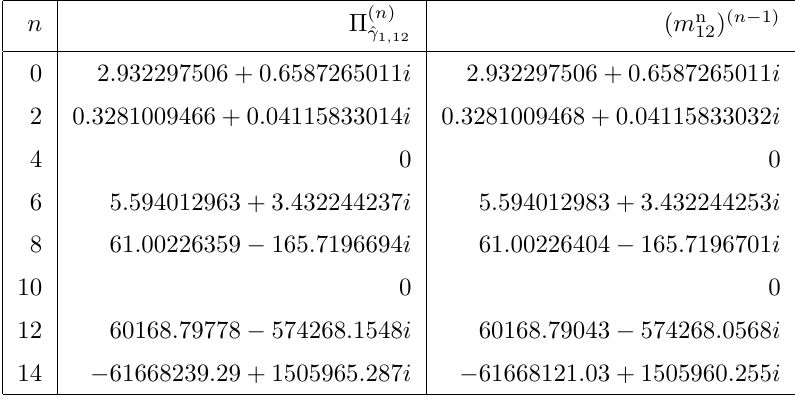
Table 5. Π ( n ) and ( m n ) ( n − 1) for the third order ODE with p ( x ) = − x 3 − ix 2 + (1 − i ) x 12 ˆ γ 1 , 12